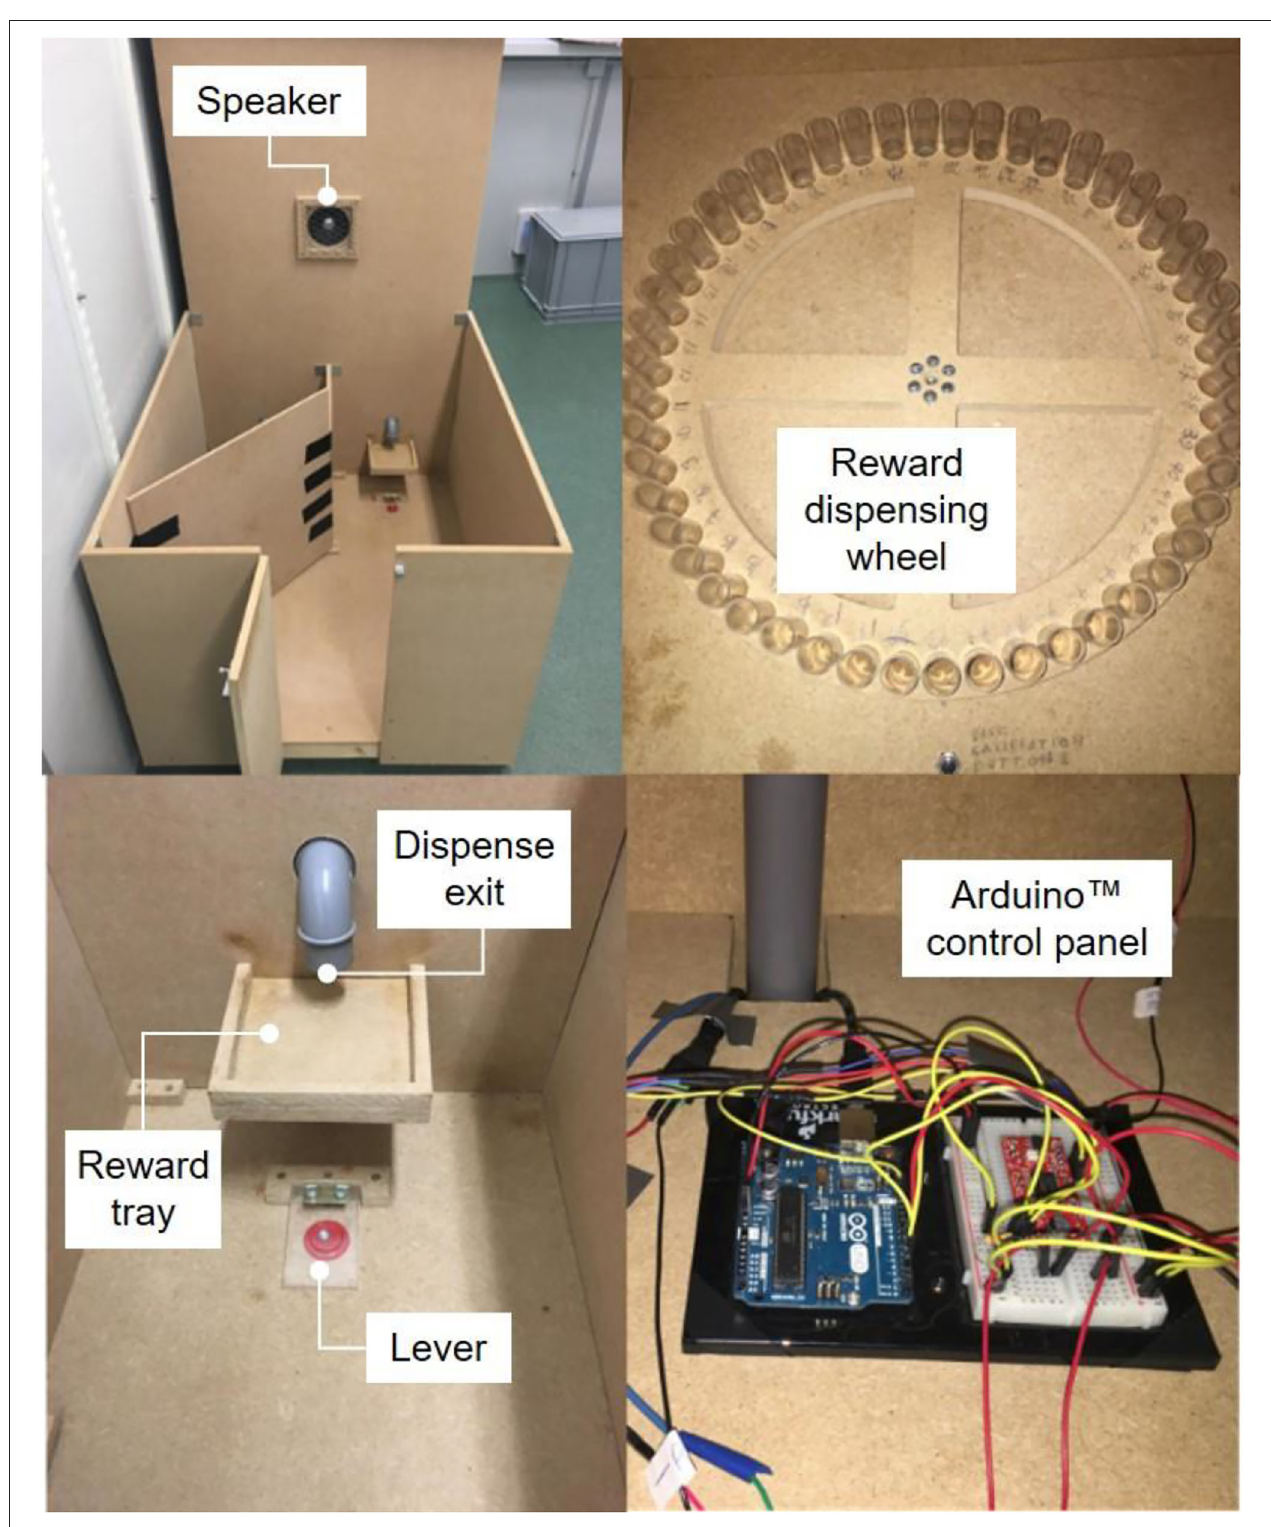
FIGURE 1 | Operant conditioning apparatus for testing food motivation in cats. The speaker emits a sound of 1,000Hz for 0.1s when the lever is pressed but no reward is dispensed and a sound of 2,000Hz for 0.2s when a food reward (one kibble) is dispensed. The reward is dispensed from the wheel at the top of the apparatus to the reward tray. The Arduino open-source electronics platform enabled the sound cues and scheduling of food rewards (Photo credit: Anqi Li).